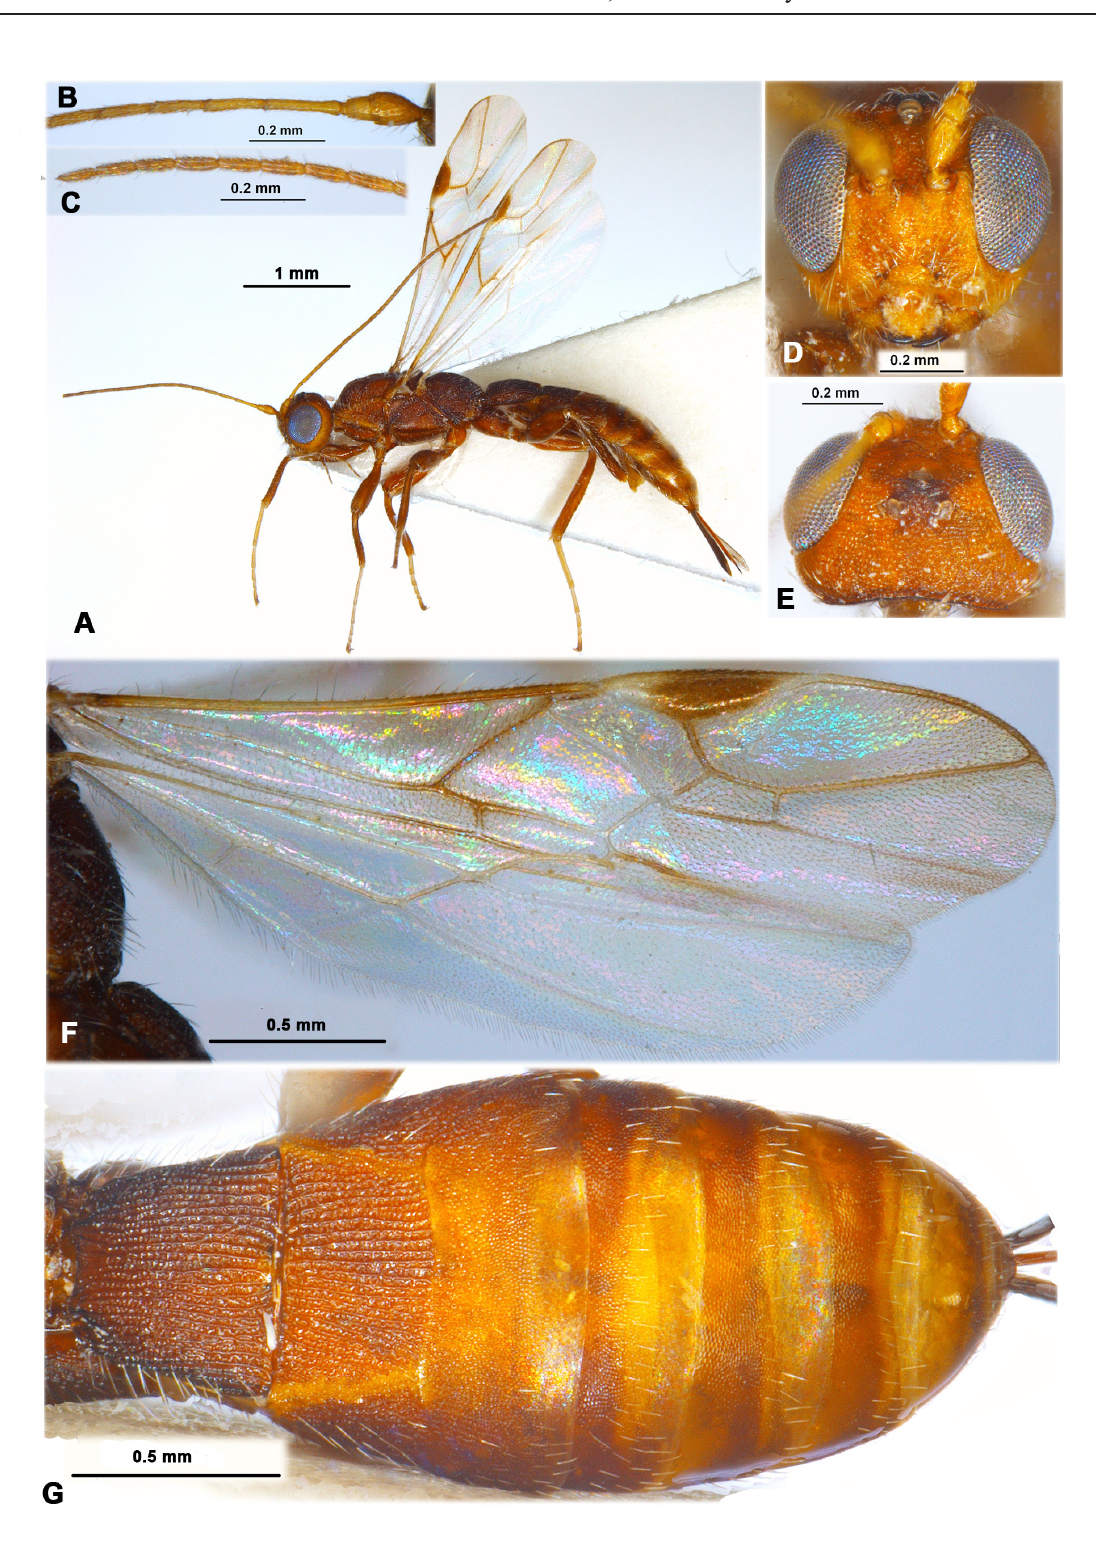
Fig. 11. Mimodoryctes arabicus Edmardash, Gadallah & Soliman, 2020, ♀ (RMNH). A . Habitus, lateral view. B . Basal segments of antenna. C . Apical segments of antenna. D . Head, front view. E . Head, dorsal view. F . Wings. G . Metasoma, dorsal